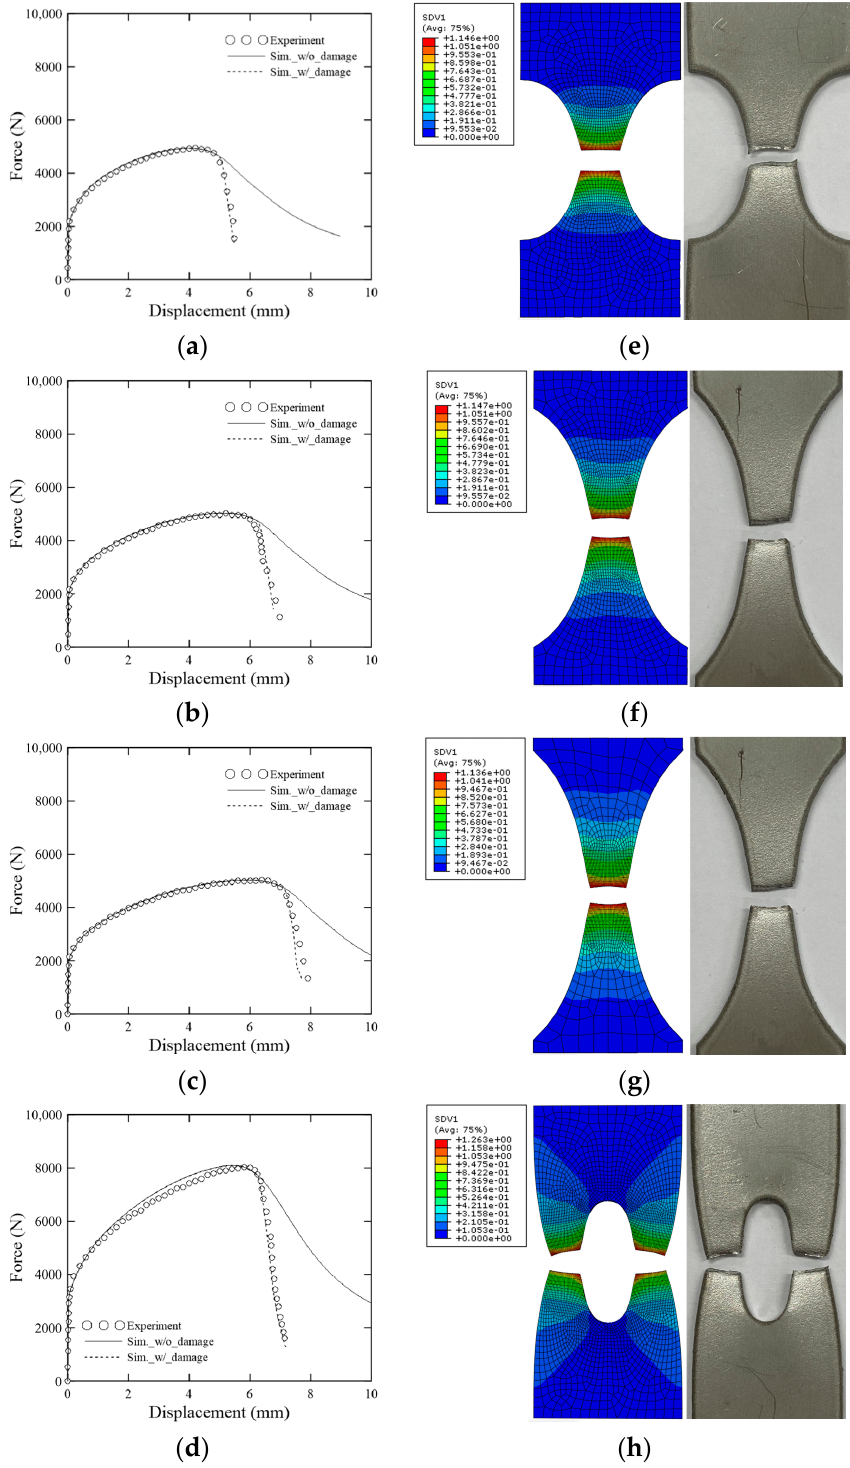
Figure 11. Comparison of force–displacement curve of ( a ) NT05, ( b ) NT10, ( c ) NT15, and ( d ) CH03 specimens and deformed configuration of ( e ) NT05, ( f ) NT10, ( g ) NT15, and ( h ) CH03 between exper- imental and simulation results (SDV1: equivalent plastic strain). With the Modified Mohr–Coulomb fracture criterion satisfied, crack propagation of the specimen occurs and complete failure follows. The fractured configurations between the numerical analysis and experiments are almost